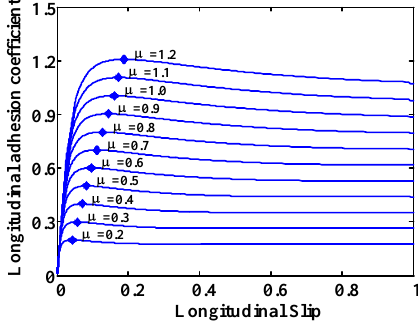
Figure 10. Approximated CarSim ® adherence vs. slip curves.